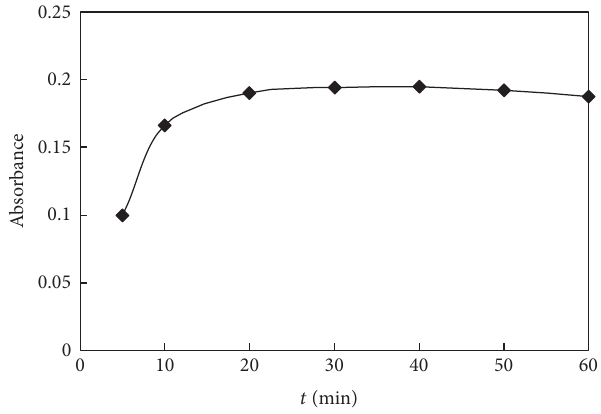
F 7: Effect of equilibration time on the absorbance of Co(II). Equilibration temperature of 80